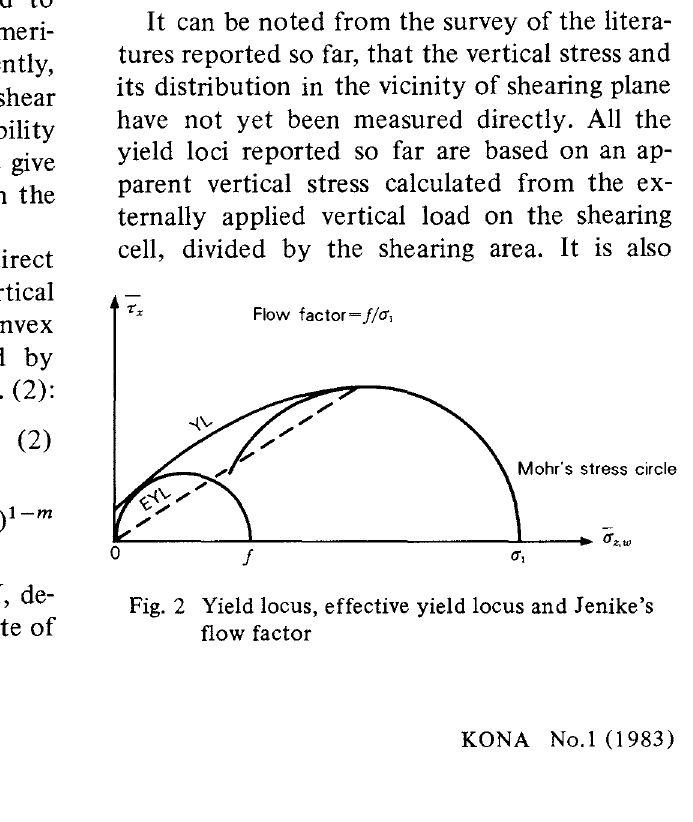
Fig. 2 Yield locus, effective yield locus and Jenike's flow